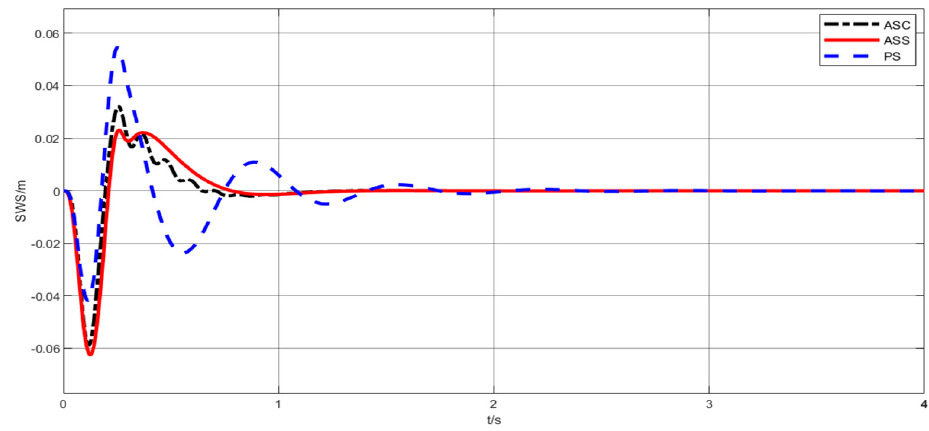
Figure 14. Bump suspension working space responses of different suspensions with 20% mass variation.